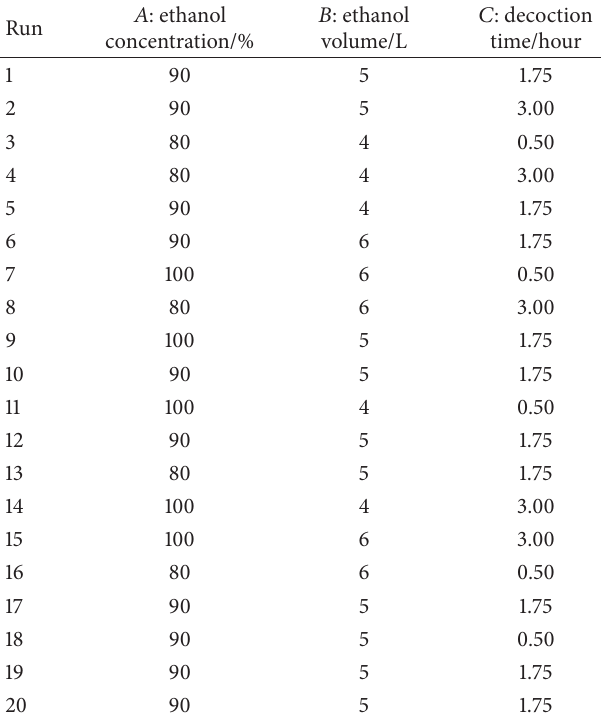
Table 2: Experiment schedules of Salvia miltiorrhiza alcohol extrac- tion ( 𝛼 = 1